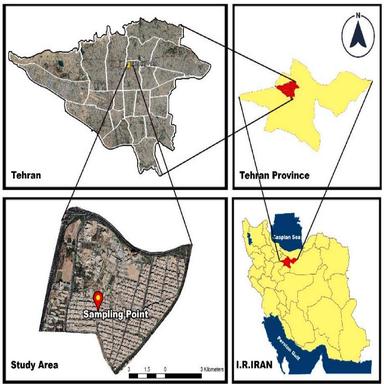
PM2.5 sampling Point.